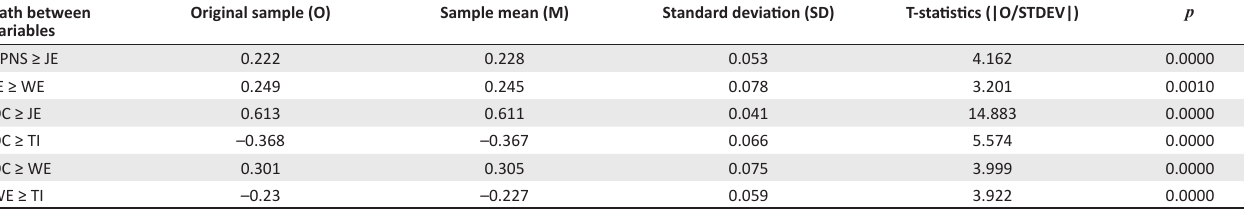
TABLE 8: Inner model (Round 2).